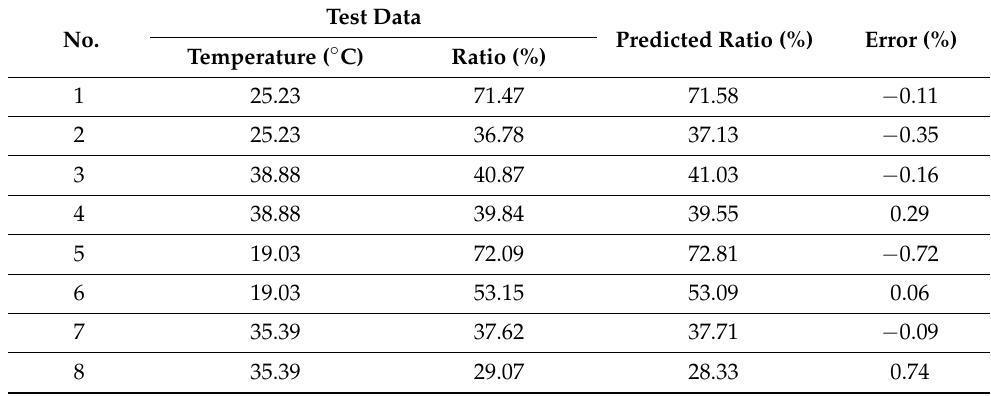
Figure 19. Loss with epoch number graph. Table 1. Test result of the learned ANN